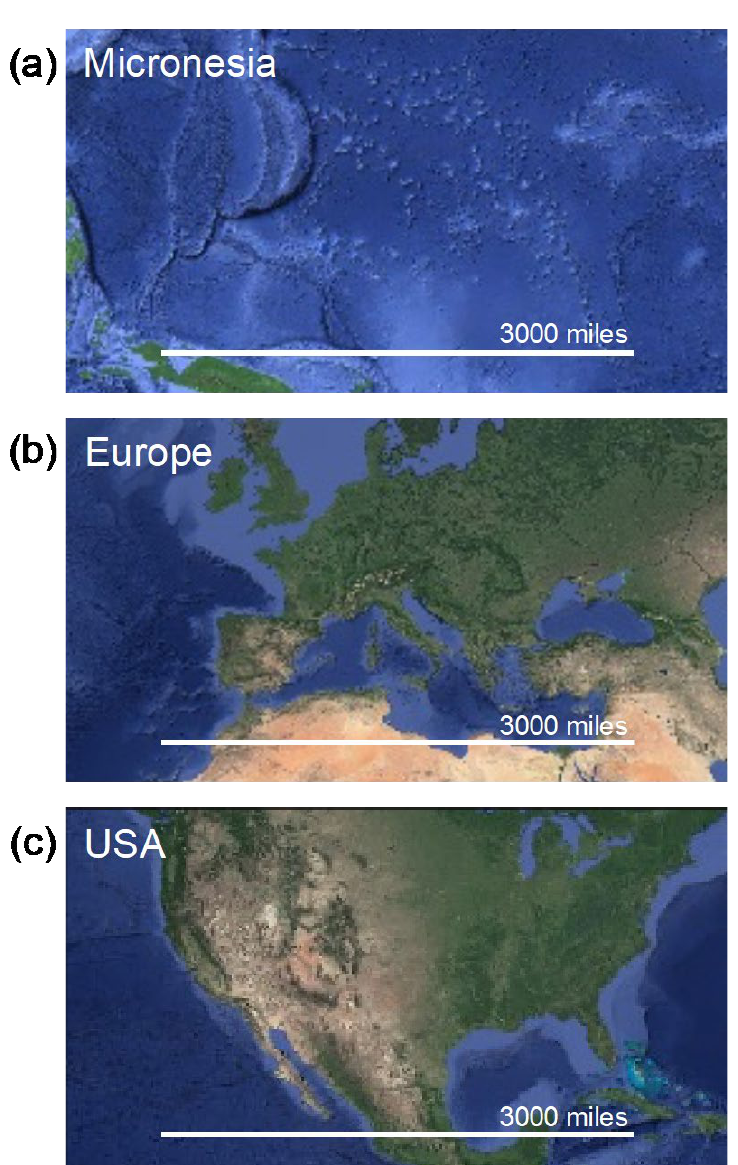
Figure 2. Satellite images displaying the relative size of ( a ) the Micronesian region within the continent of Oceania, ( b ) the continent of Europe, and ( c ) the United States of America. The white bar approximates 3000 miles to scale for all images. Adapted Google maps satellite images used with permission. Imagery ©2022 NASA, Terrametrics, Map Data ©2022.